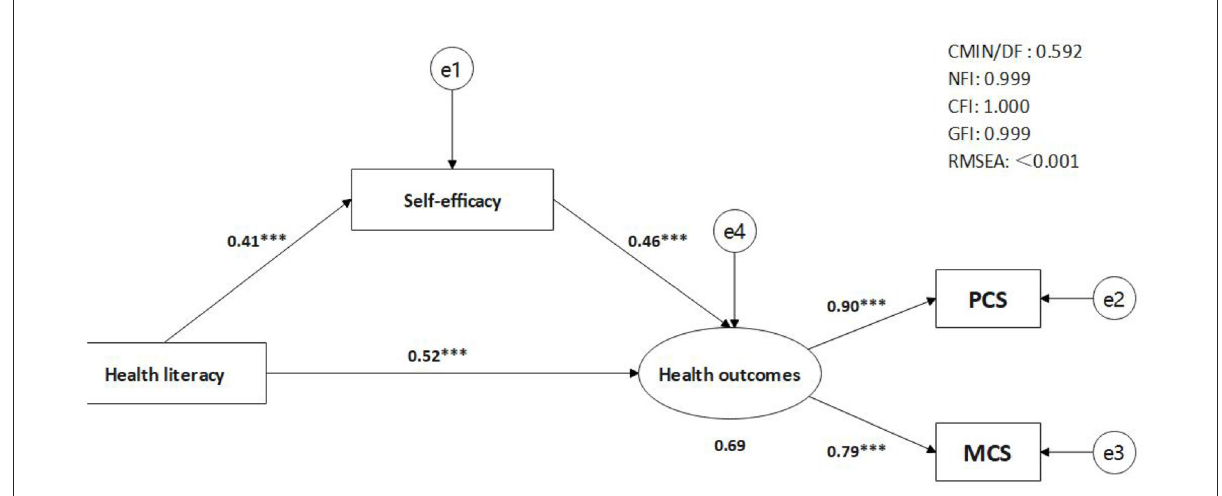
FIGURE2 The mediation model. PCS, physical component summary; MCS, mental component summary. *** p < 0.001.